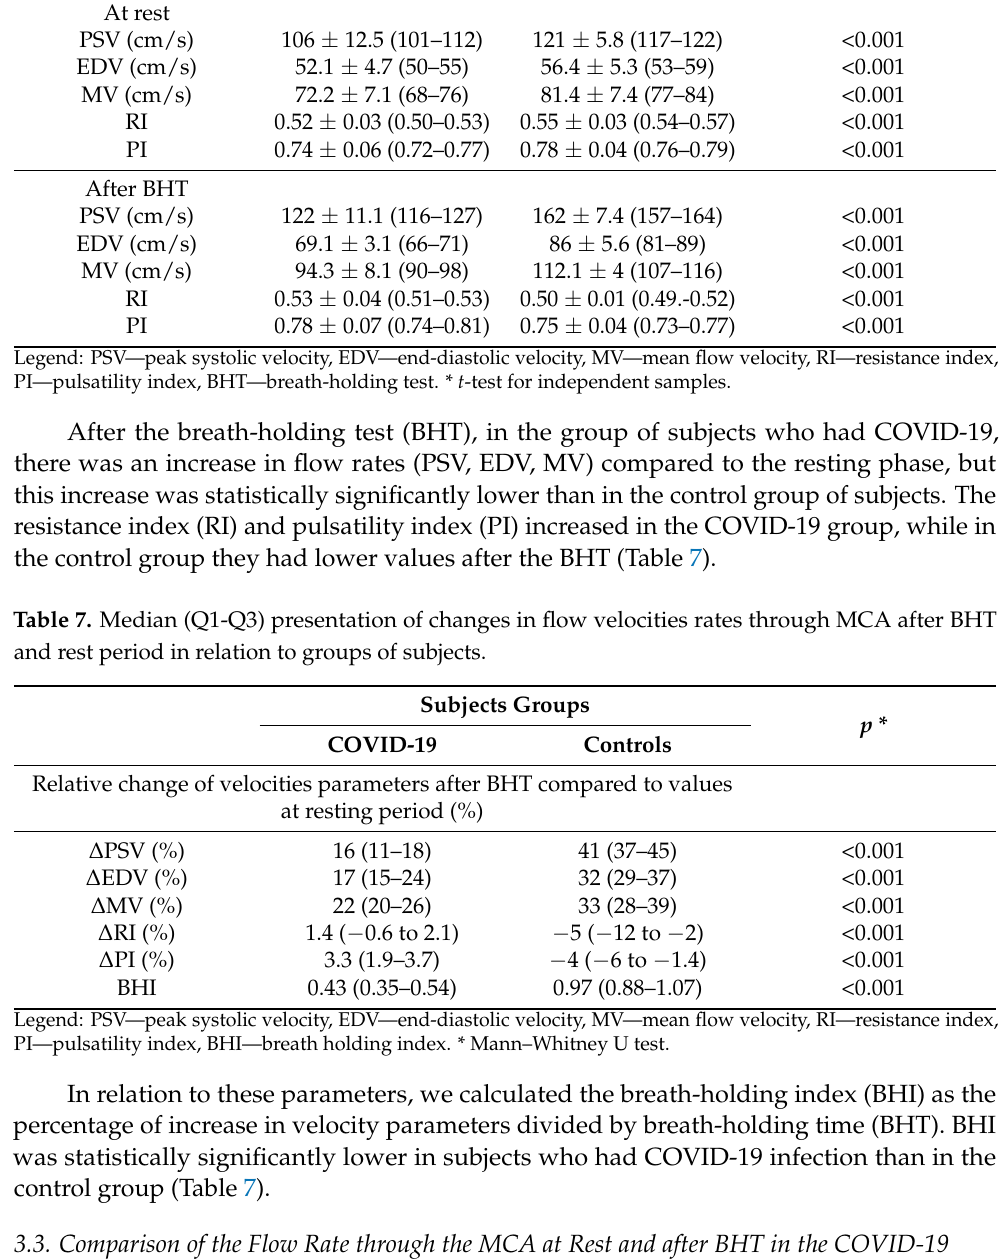
Table 6. Arithmetic means of flow velocities through MCA and standard deviations ( ± SD) (95% CI) of these parameters.